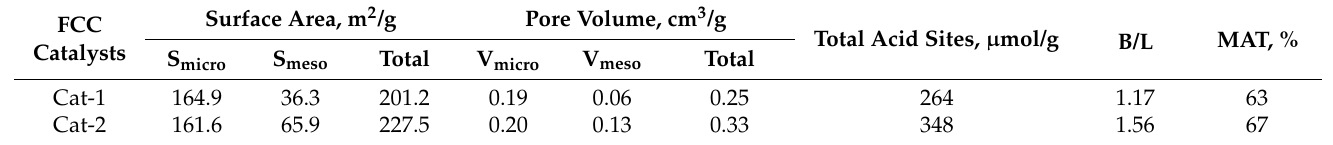
Table 3. Physicochemical properties for prepared FCC catalysts.